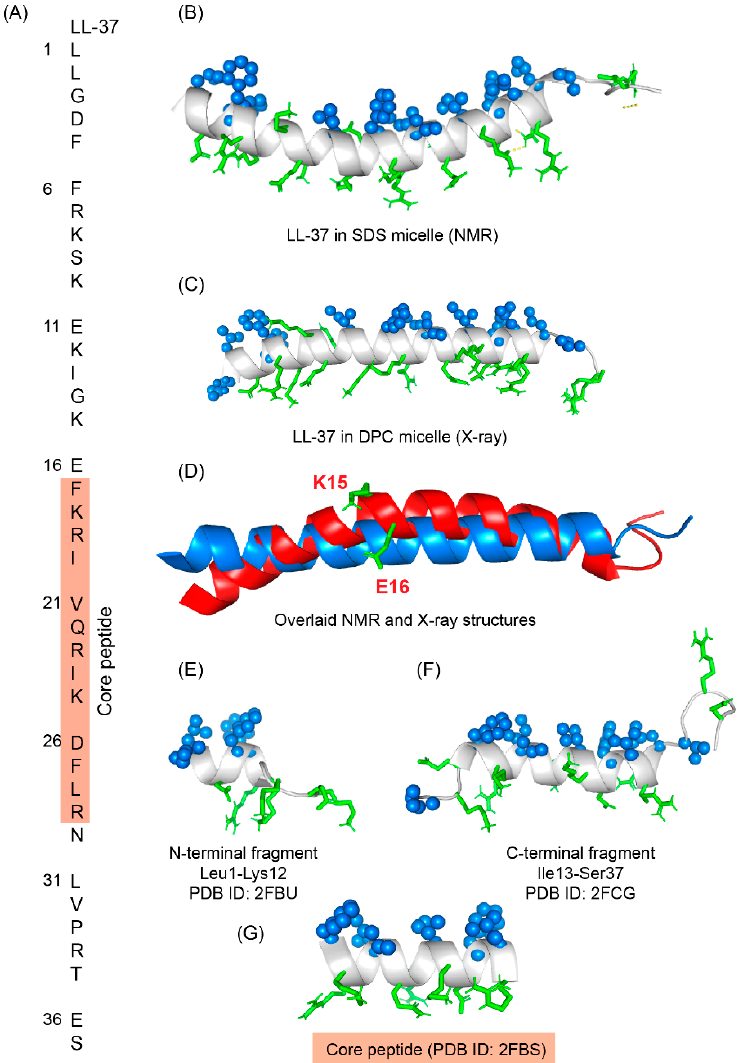
Figure 6. ( A ) Amino acid sequence of LL-37 peptide; core peptide is highlighted by maroon-colored box. ( B ) LL37 adopted a twisted amphipathic α -helical conformation in presence of SDS micelle (PDB: 2K6O) [134] . ( C ) In presence of DPC micelle, the peptide obtained a straight helical confor-